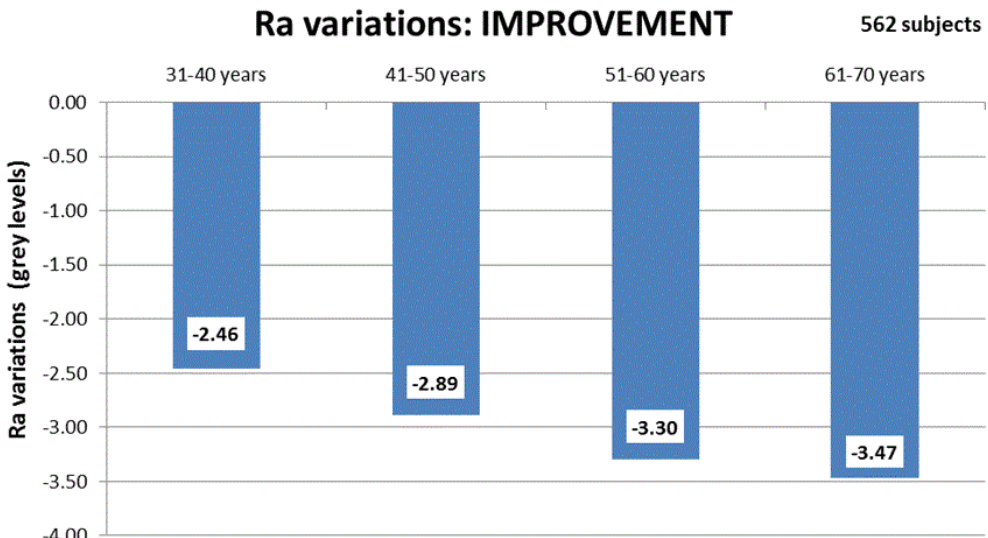
Figure 7. Improvements in skin roughness values (Ra and Rz parameters) at the end of a cosmetic treatment as a function of the age group. Statistical comparison among the age groups: p > 0.05